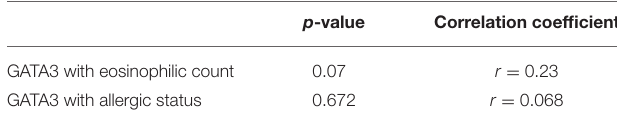
TABLE 5 | Correlation between GATA-3 with eosinophilic count and allergic status.